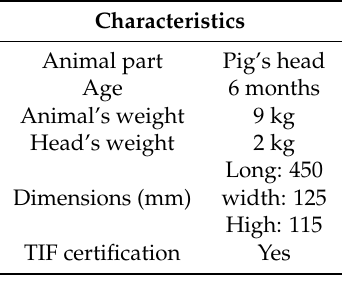
Table 4. Dimensions, weights, and sample’s age for the validation